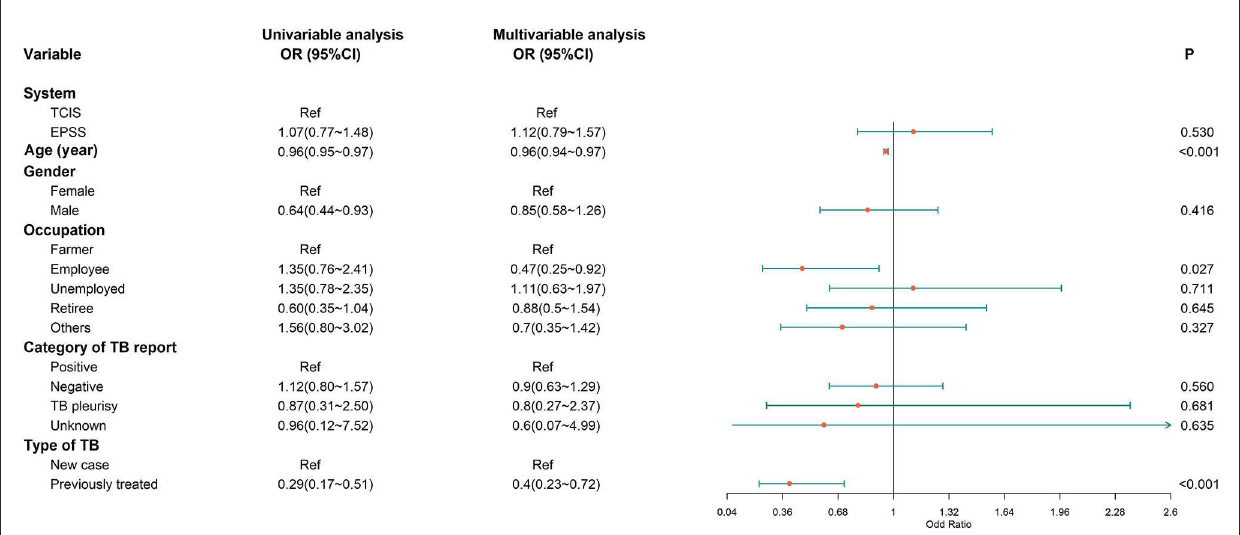
FIGURE5 Multivariate logistic regression analysis on the factors associated with favorable treatment outcomes. Favorable treatment outcome, cured or treatment completed; OR, odds ratio; CI, confidence interval; model was adjusted for age, gender, occupation, category of TB report, and type of TB.